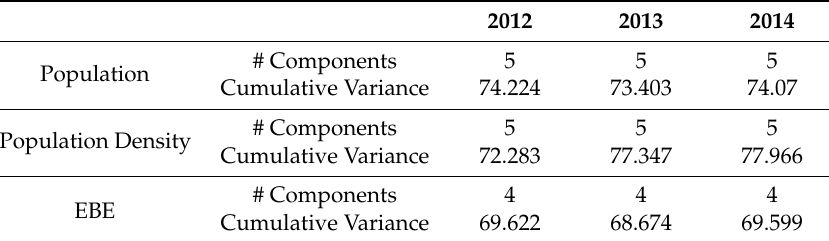
Table 2. Principal components analysis results.